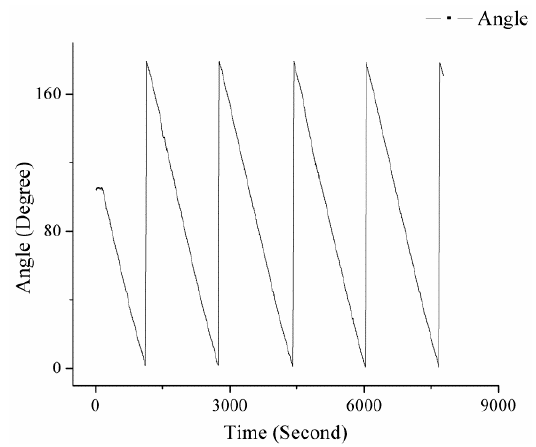
Figure 8. Angle measured throughout the system, which is uniformly rotated at a rate of 1° per second.